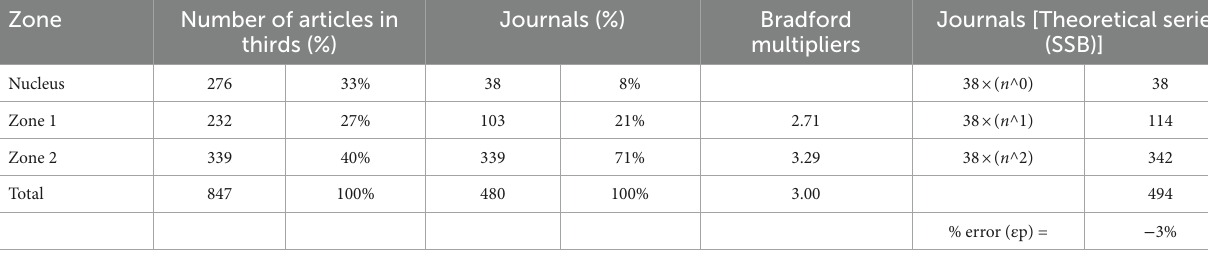
TABLE 2 Bradford zones estimation, articles by journal